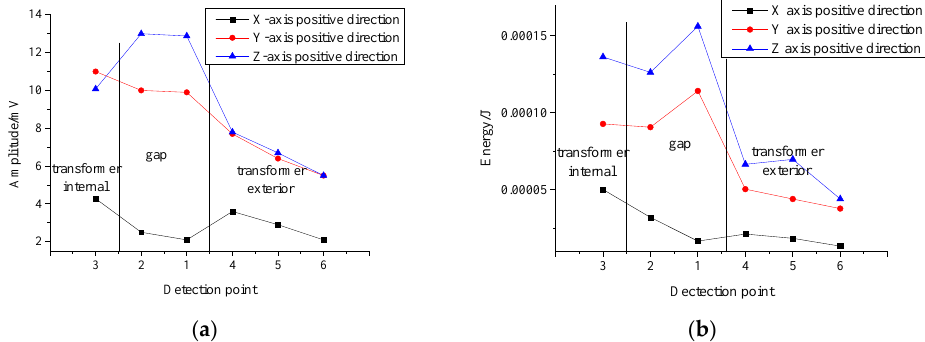
Figure 17. Distributions of electromagnetic signals radiated by PD source in different directions in experiment: ( a ) Amplitude distribution; ( b ) Cumulative energy distribution.